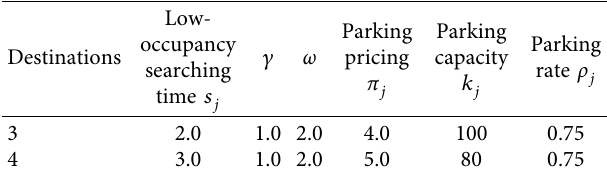
Table 3: The parameters of parking strategy at